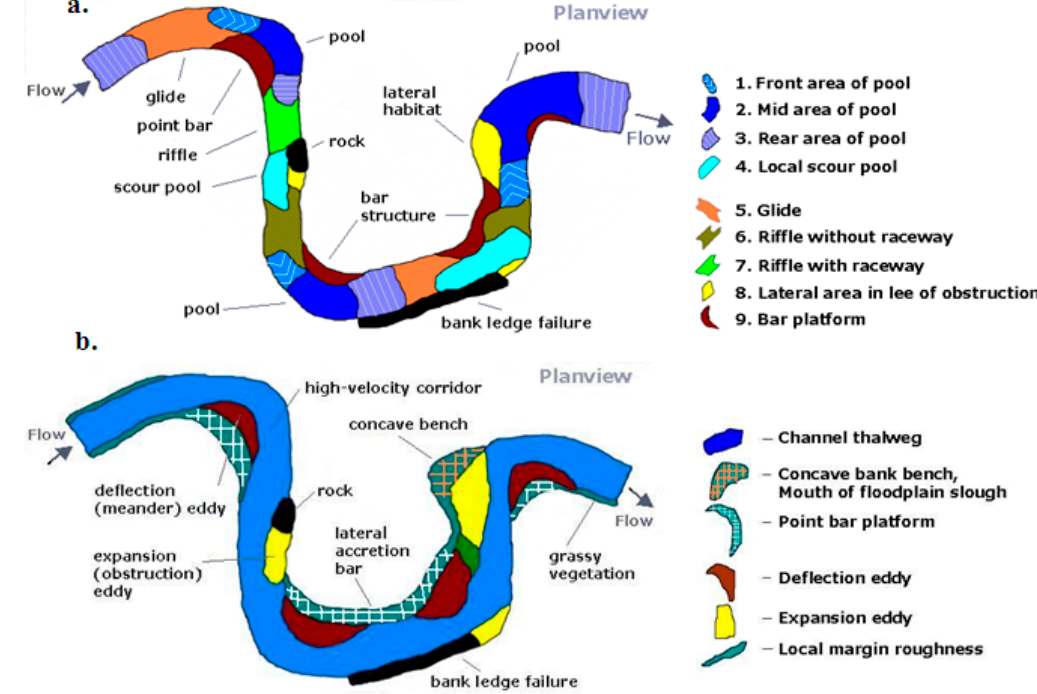
Figure 5. Illustration of a spatial arrangement of mesohabitat units at: ( a ) baseflow stage, changing to units; and ( b ) high-flow stage for the same channel reach.